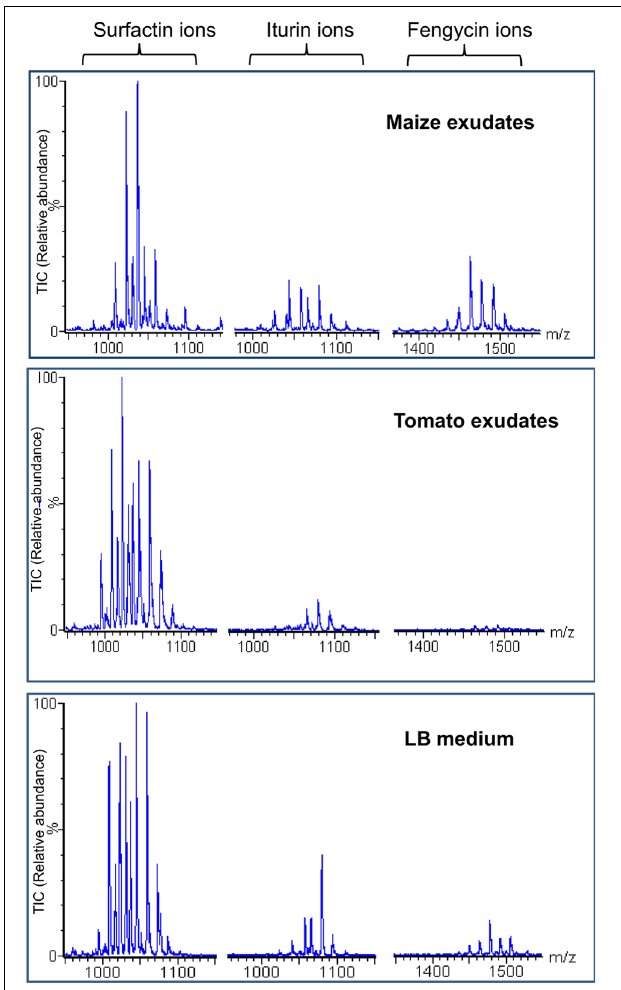
FIGURE 3 | Efficient production of fengycins by strain S499 in maize exudates. Extracted ion chromatograms of each lipopeptide family obtained by UPLC-ESI-MS analysis of extracts prepared from supernatants collected after cultivation of strain S499 in the three different media indicated. For each LP family, several peaks are detected which correspond to the various co-produced homologes differing in the length/isomery of the fatty acid tail. Y-axes representing the relative abundance of the ions are linked to the same scale.